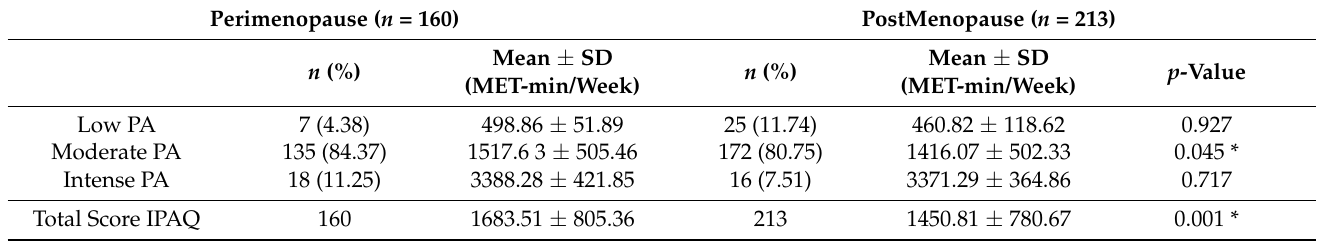
Table 1. Total score and physical activity levels of the study population According to the IPAQ.